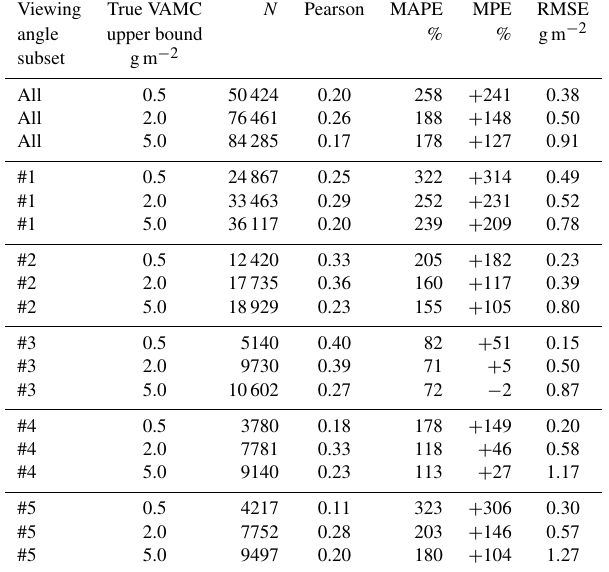
Table 1. Statistical evaluation of VAMC from VADUGS against simulated observations (representing the truth).